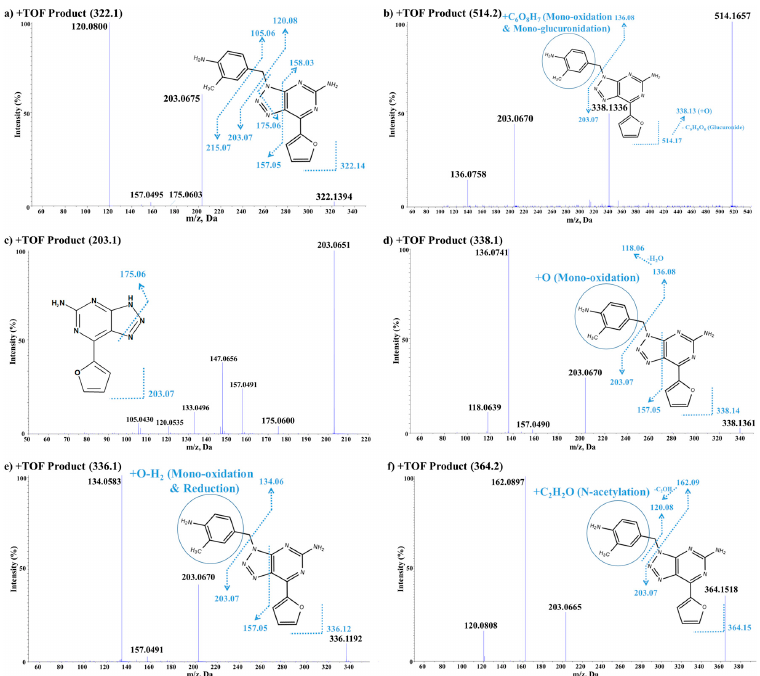
Figure 5. Identification of in vitro/vivo metabolites based on vipadenant. ( a ) TOF-MS/MS scan of vipadenant ( m / z 322.1); ( b ) TOF-MS/MS scan of ‘mono-oxidation and mono-glucuronidation’ metabolite (M1: m / z 514.1); ( c ) TOF-MS/MS scan of the metabolite with a ‘loss of C 8 H 9 N’ moiety from vipadenant (M2: m / z 203.1), ( d ) TOF-MS/MS scan of ‘mono-oxidation’ metabolites (M3, M4, M5, M7: m / z 338.1); ( e ) TOF-MS/MS scan of metabolites with ‘mono-oxidation followed by reduction’ (M6, M9, M10: m / z 336.1) and ( f ) TOF-MS/MS scan of ‘acetylated’ metabolites (M8: m / z 364.1).